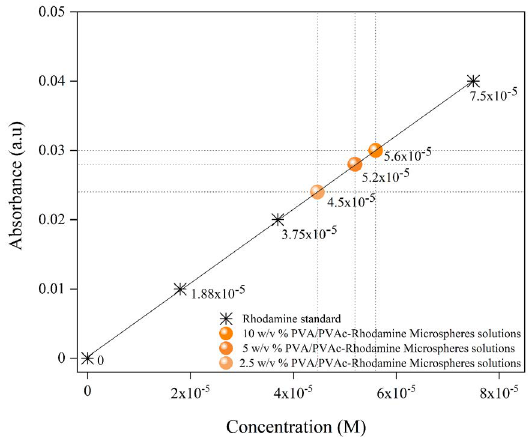
Figure 11. Calibration curve showing the measured values of absorbance corresponding to the Rhodamine 0 to 7.5 10 -5 M standard solutions. Also the absorption values measured for the 10 w/v %, 5 w/v % and 2.5 w/v % PVA/PVAc-Rhodamine microspheres.